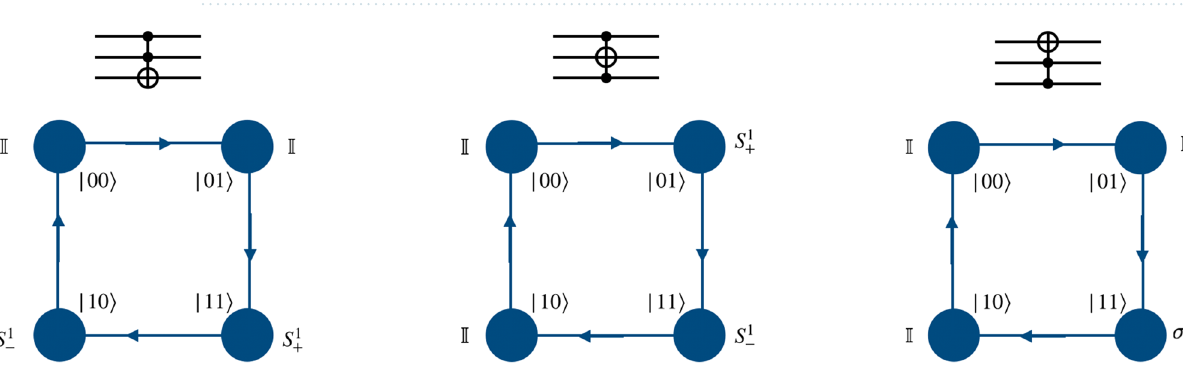
j is given in Eq. (2). ±